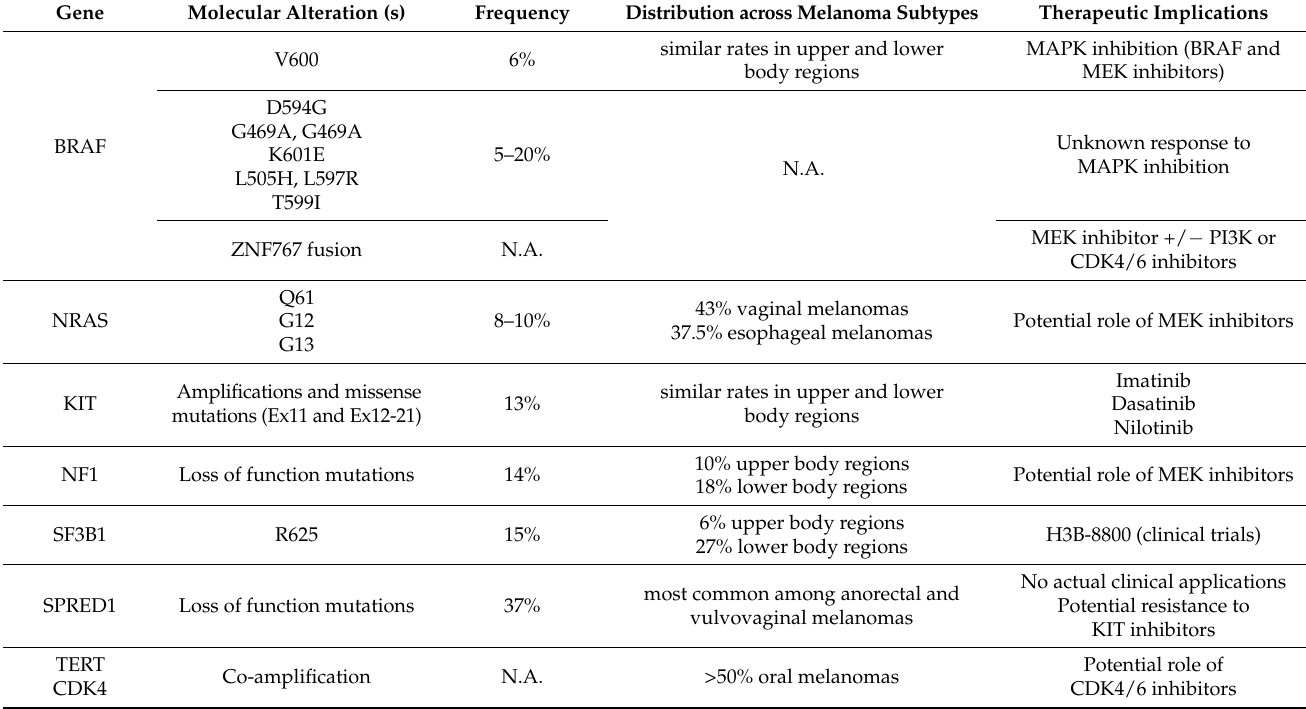
Table 1. Summary of most common genetic alterations in mucosal melanoma